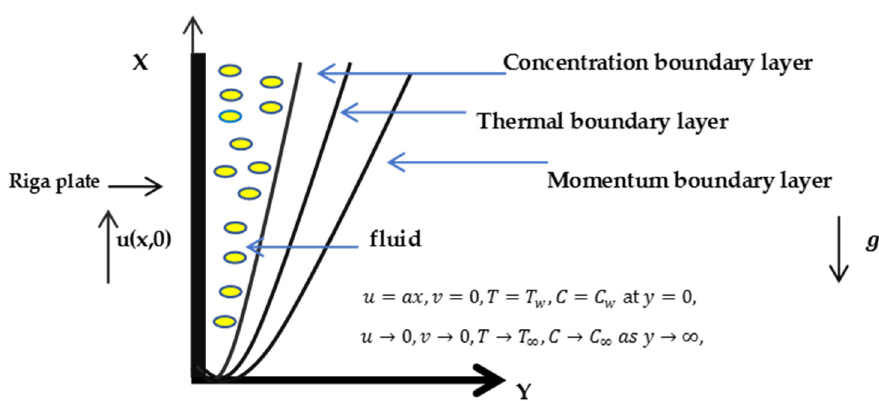
Figure 1. Geometry of the Riga plate.